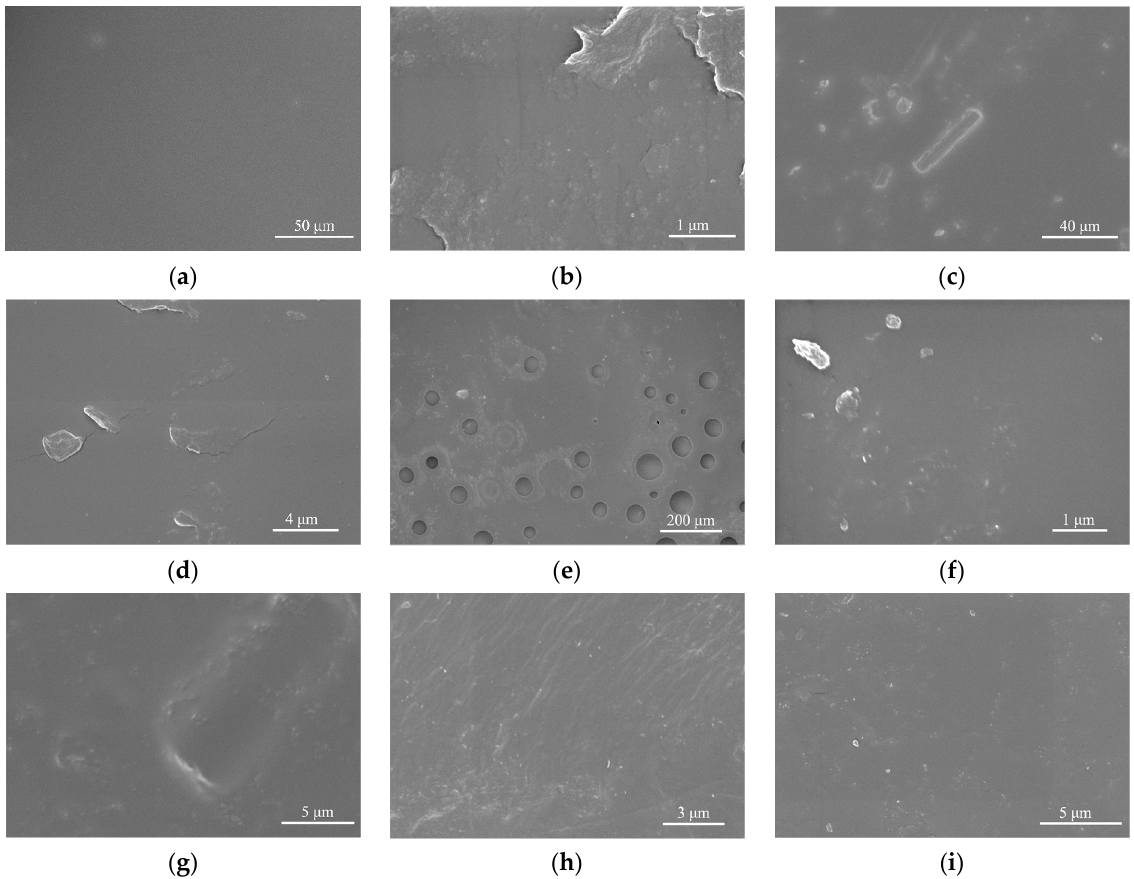
Figure 4. The SEM images of pure and functional PU films: ( a ) F1 (WD = 8.2 mm, EHT = 2.0 kV); ( b ) F2 (WD = 8.2 mm, EHT = 2.0 kV); ( c ) F3 (WD = 8.3 mm, EHT = 2.0 kV); ( d ) F4 (WD = 8.1 mm, EHT = 2.0 kV); ( e ) F5 (WD = 8.2 mm, EHT = 2.0 kV); ( f ) F6 (WD = 8.1 mm, EHT = 2.0 kV); ( g ) F7 (WD = 7.6 mm, EHT = 2.0 kV); ( h ) F8 (WD = 8.2 mm, EHT = 2.0 kV); ( i ) F9 (WD = 8.2 mm, EHT = 2.0